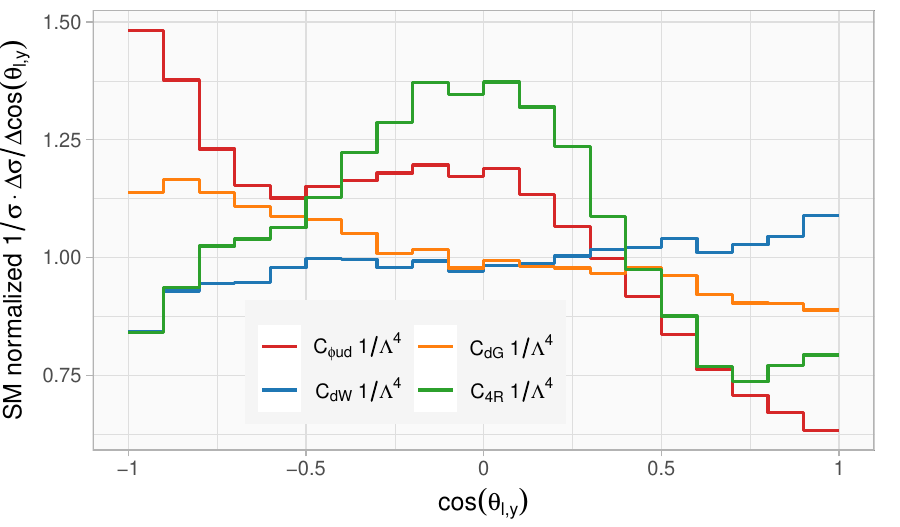
Figure 24. To itself and to the SM normalized SMEFT contributions to the cos (cid:18) l;y distribution at NLO in QCD . Results are presented for Q 33 operator Q 4 R .